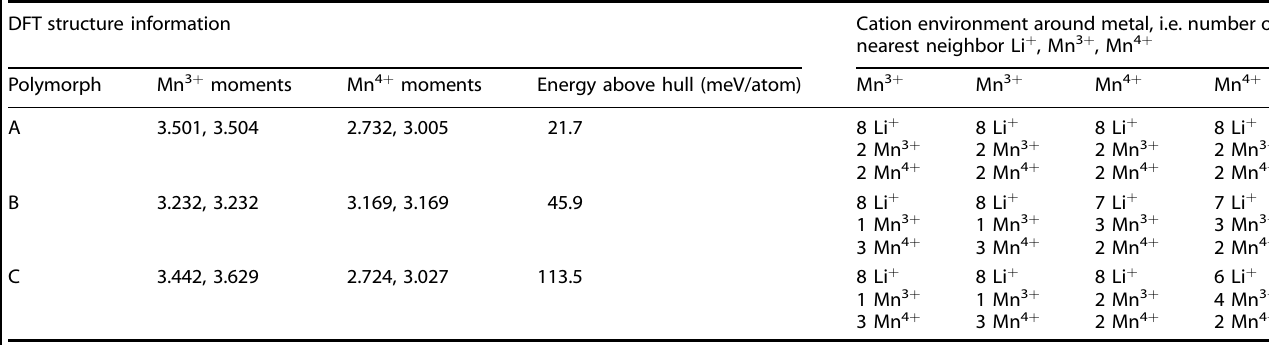
Table 1. Description of three polymorphs of composition Li 6 Mn 4 O 10